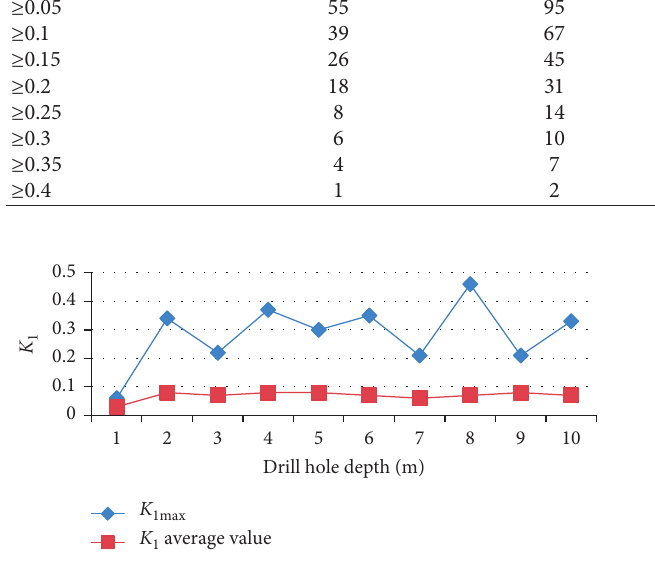
Figure 25: Distribution of 58 sets prediction cycle cuttings de- sorption index K 1 at different hole depths.